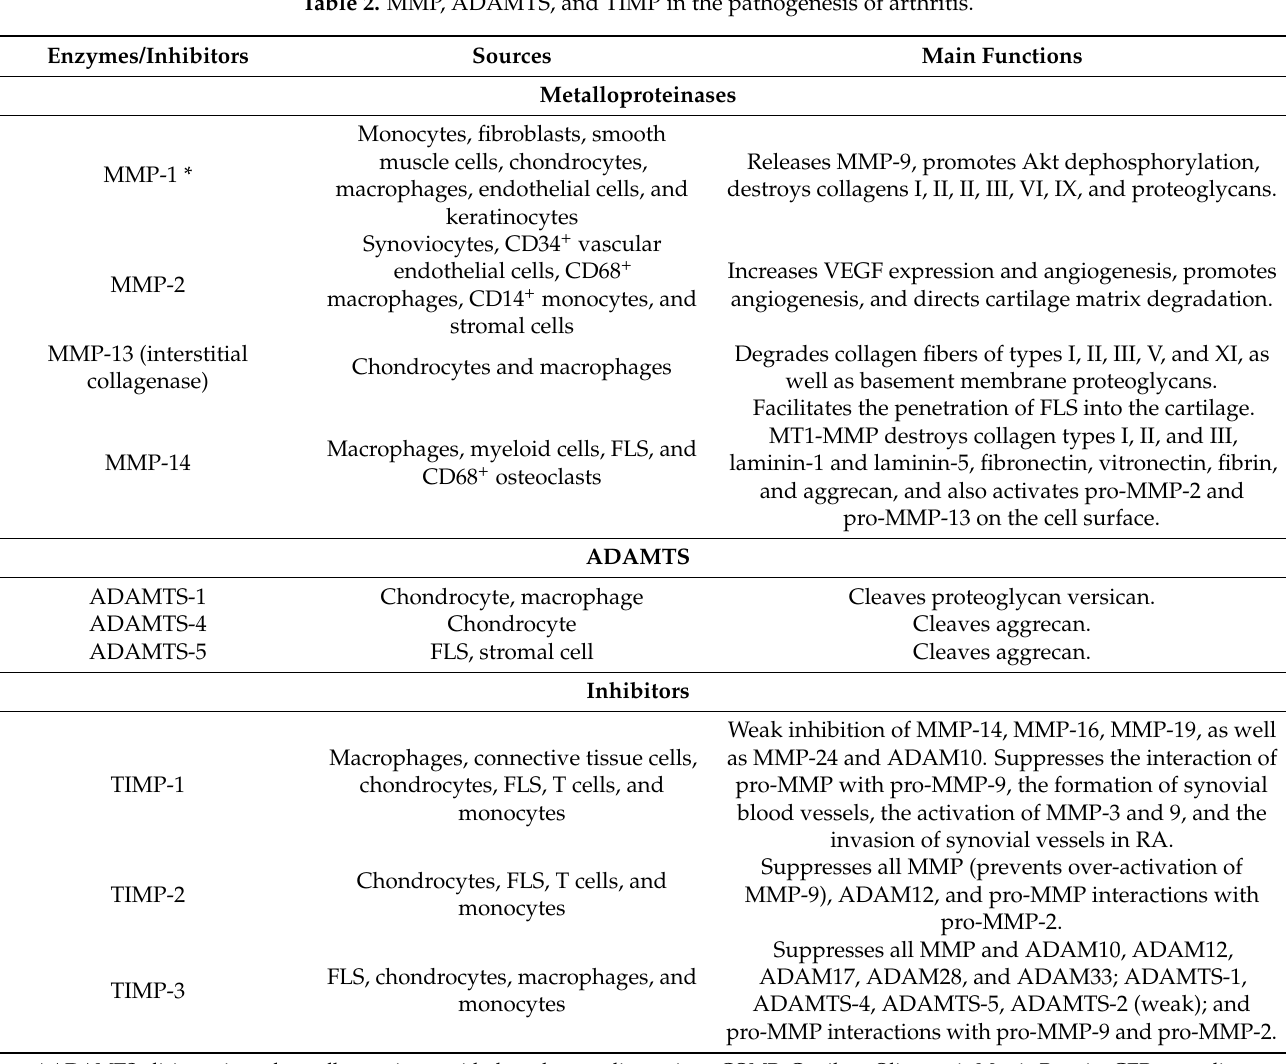
Table 2. MMP, ADAMTS, and TIMP in the pathogenesis of